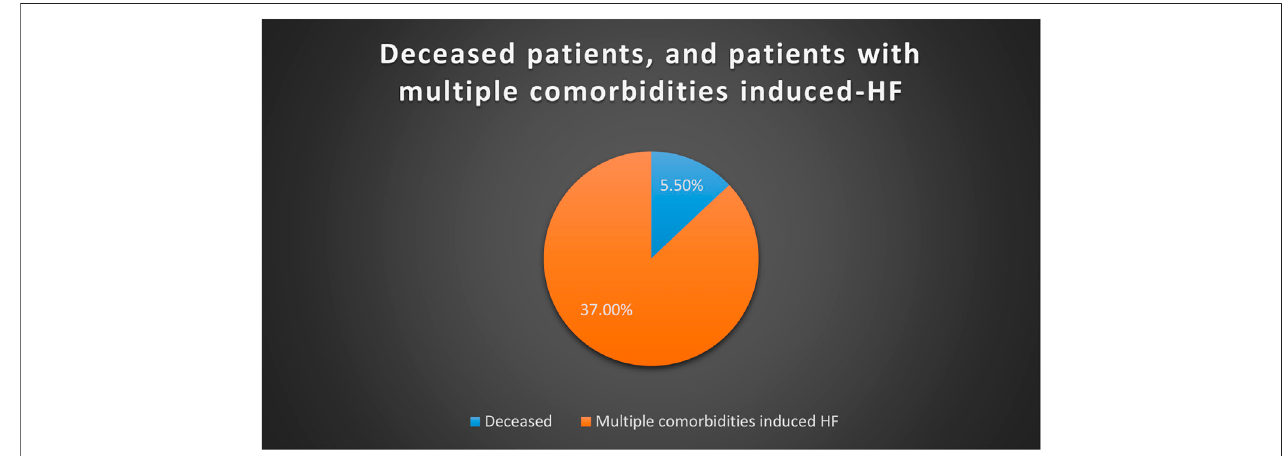
FIGURE 1 | Pie chart for deceased patients, and patients with multiple comorbidities induced-HF.